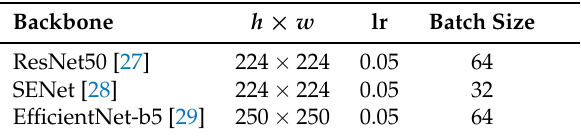
Table 1. Training hyperparameters for different